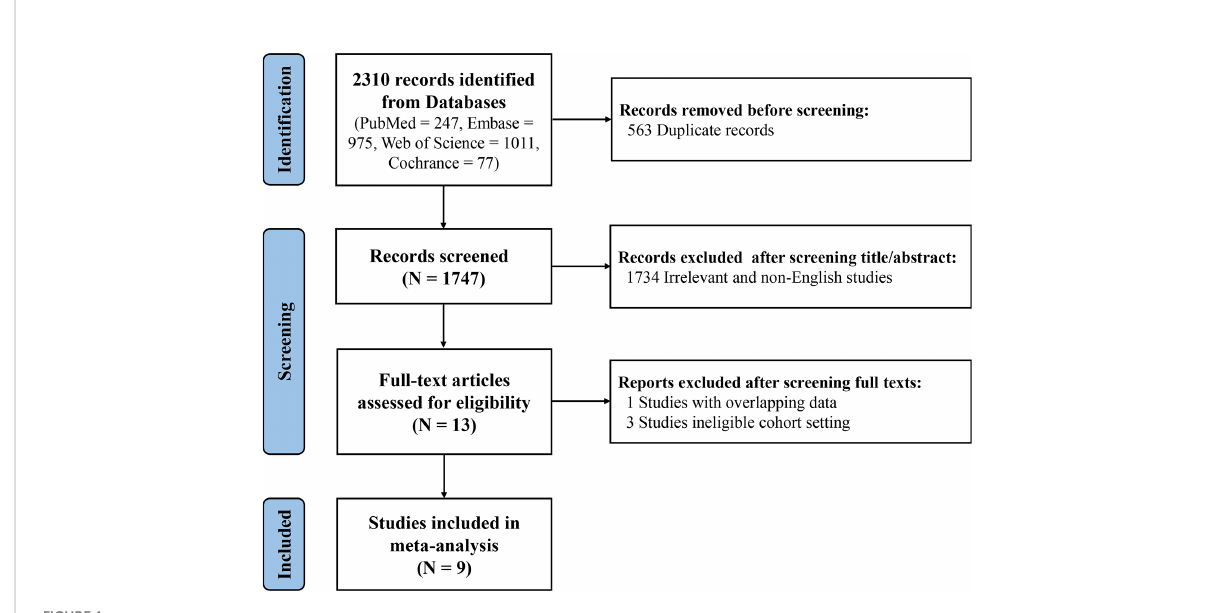
FIGURE 1 PRISMA 2020 Flow